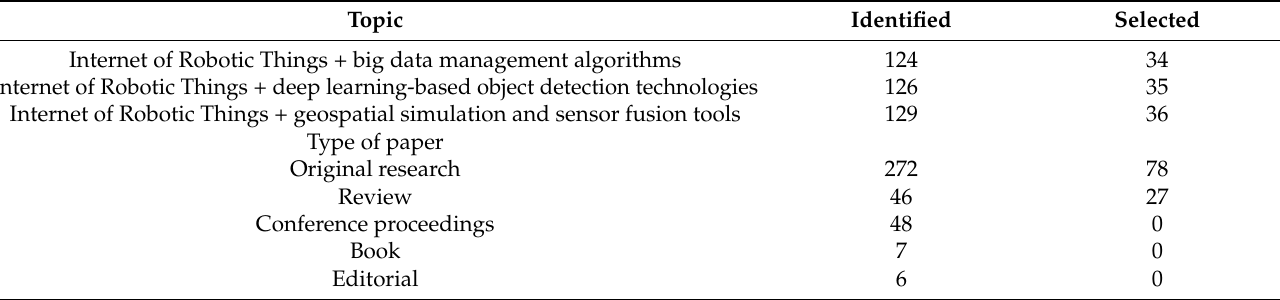
Table 1. Topics and types of identified and selected scientific products. Topic Identified Selected